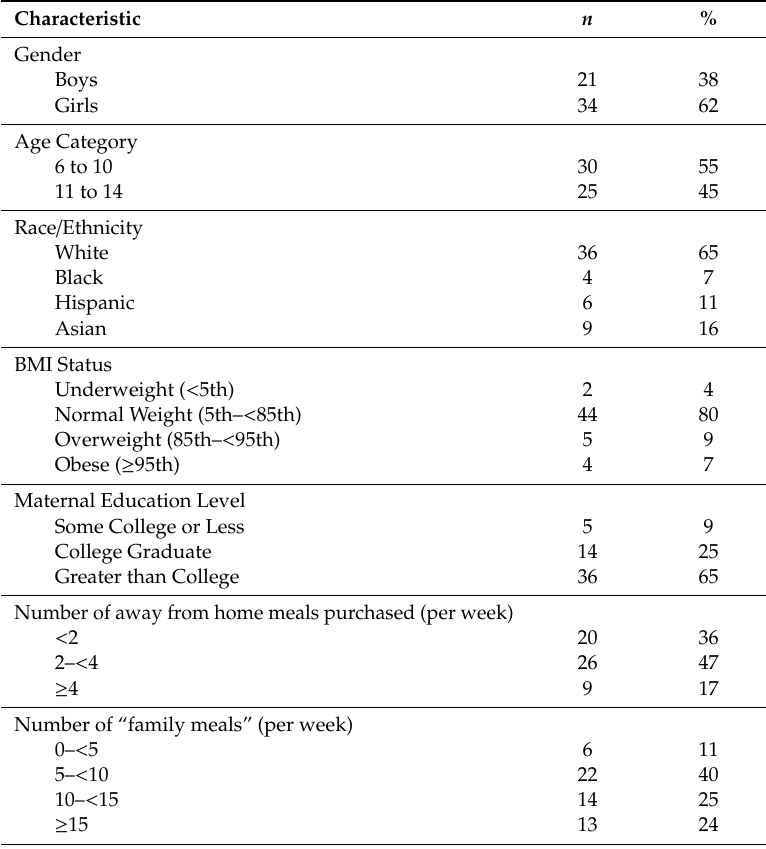
Table 1. Baseline characteristics of participants in the pilot study ( n =